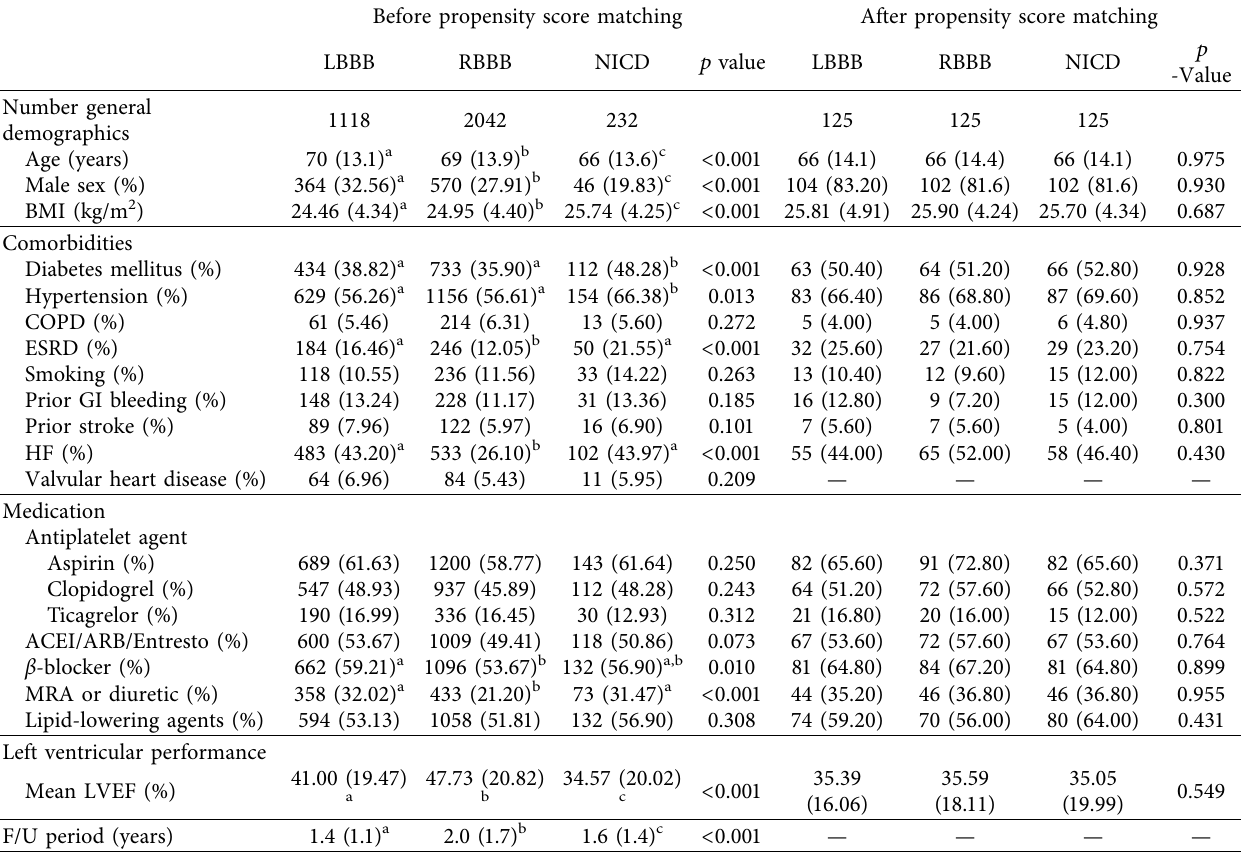
— — — Data are expressed as mean (standard deviation) or as number (percentage). Different letters (a, b) associated with different groups indicate significant difference (at 0.05 level) by Bonferroni multiple comparison procedure. Abbreviation: LBBB: left bundle branch block; RBBB: right bundle branch block; NICD: nonspecific intraventricular conduction delay; BMI: body mass index; PAOD: peripheral arterial occlusive disease; COPD: chronic obstructive pulmonary disease; ESRD: end-stage renal disease; GI: gastrointestinal; HF: heart failure; ACEI: angiotensin-converting enzyme inhibitor; ARB: angiotensin receptor blocker; MRA: mineralocorticoid receptor antagonist; LVEF: left ventricular ejection fraction; F/U: follow-up.